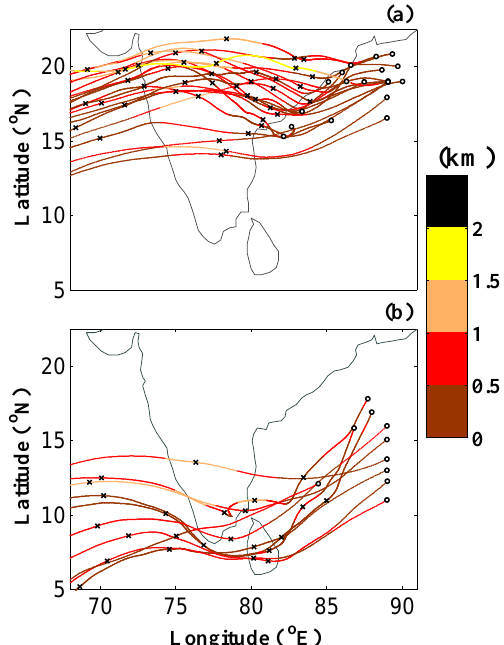
Figure 3. Five-day air mass back trajectories during the study period ending at the measurement locations (small black circles) grouped for corresponding air masses from (a) central/northern In- dia and (b) southern India. The cross symbols along the trajectories represent each back-day. The colour scale shows the height (in km) of the